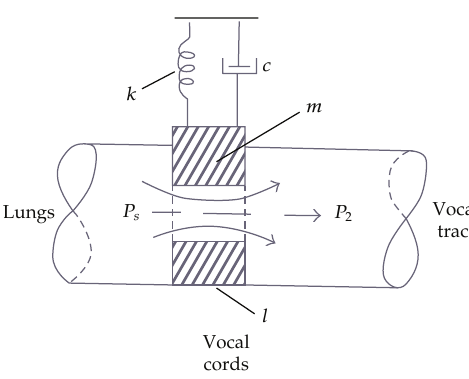
Figure 1: One-mass model of the vocal cord with one degree of freedom (cid:4) 2 (cid:5)